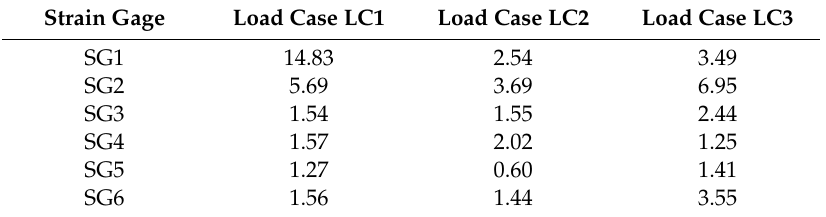
Table 5. Root-mean-square-errors between numerical and experimental strain values ( µ m / m).